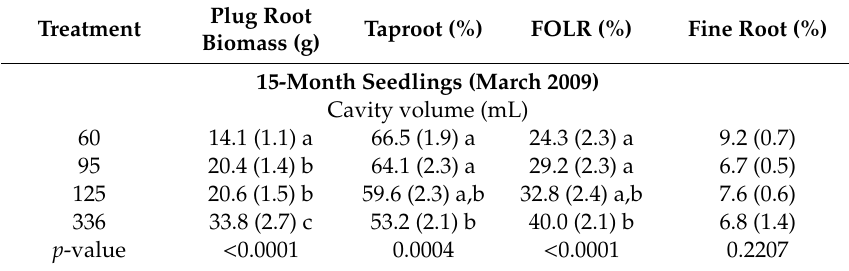
Table 6. Means (1 SE) and p -values for plug root biomass and its allocation to components (FOLR, first-order lateral roots; fine root, non-FOLR from taproot) within the root plug in response to nursery treatments among seedlings excavated 15 and 22 months after outplanting. Within each treatment and excavation, means followed by the same letter are not significantly di ff erent at the Bonferroni-adjusted 0.05